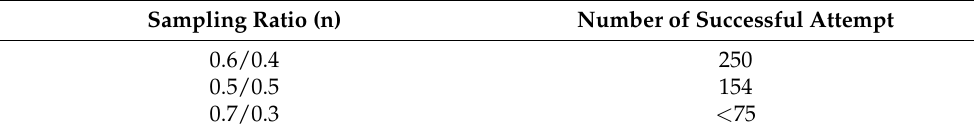
Table 4. Total successful attempts for each sampling ratio.